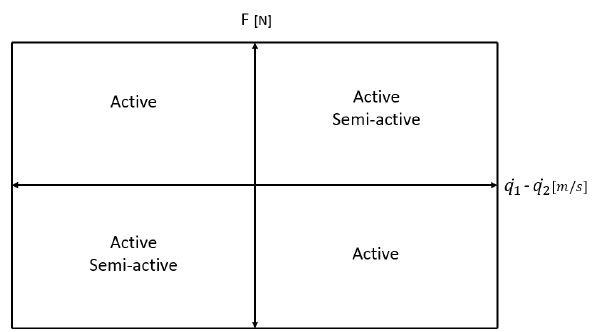
Figure 1. Quadrant comparison between active and